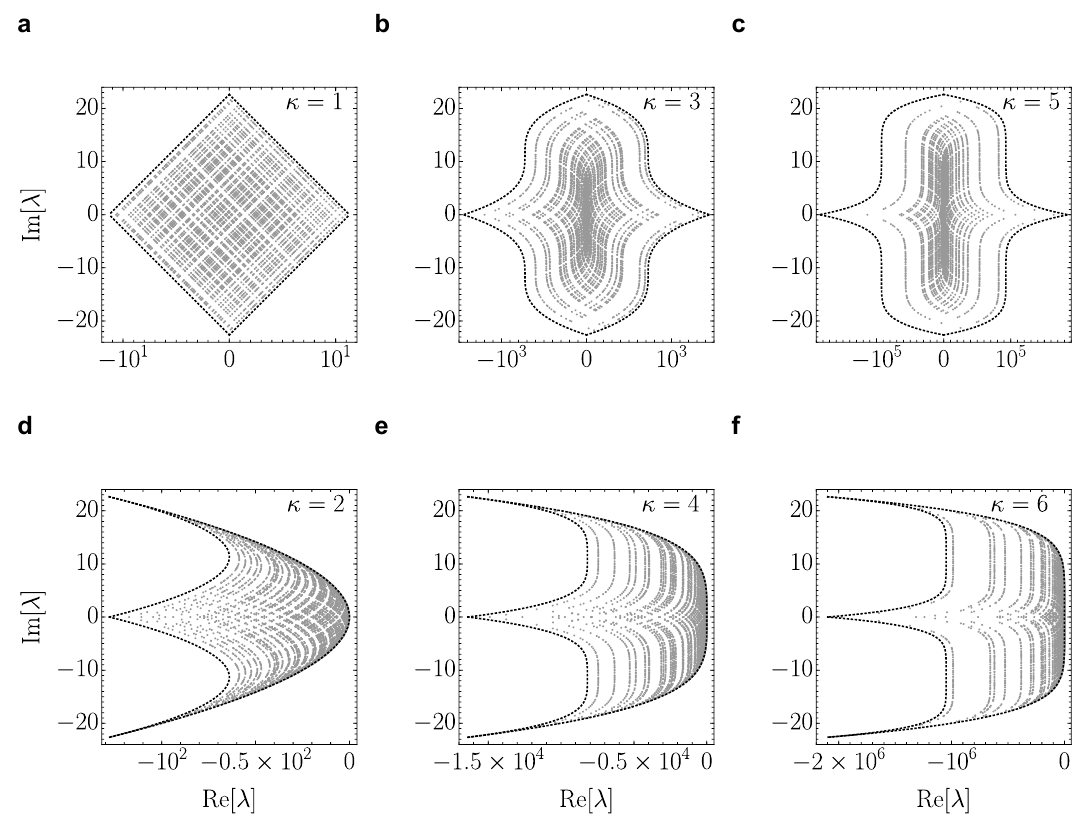
Figure 1 . Liouvillian spectra of different non-Hermitian deformations. Spectra of L ( κ ) with γ = 1 when t → ∞ , for κ = 1 , 2 , 3 , 4 , 5 , 6 (gray points) on the complex plain, together with the theoretical boundaries (dashed black lines) given by eq. (5.19) and eq. (5.20). In all six plots we show the spectrum of a single random GOE(2 6 ) Hamiltonian H 0 with σ = 1